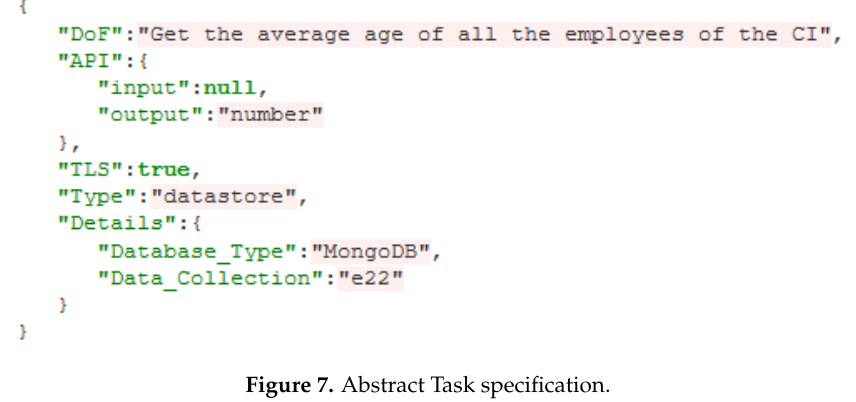
Figure 7. Abstract Task specification.